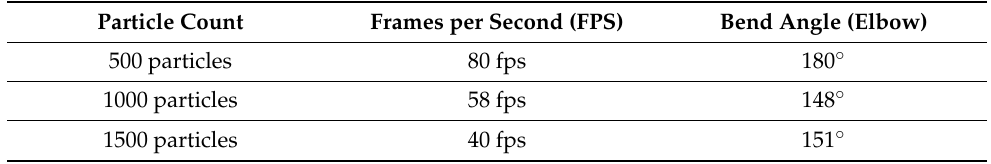
Table 1. Comparison of fps and bend angles by particle count.